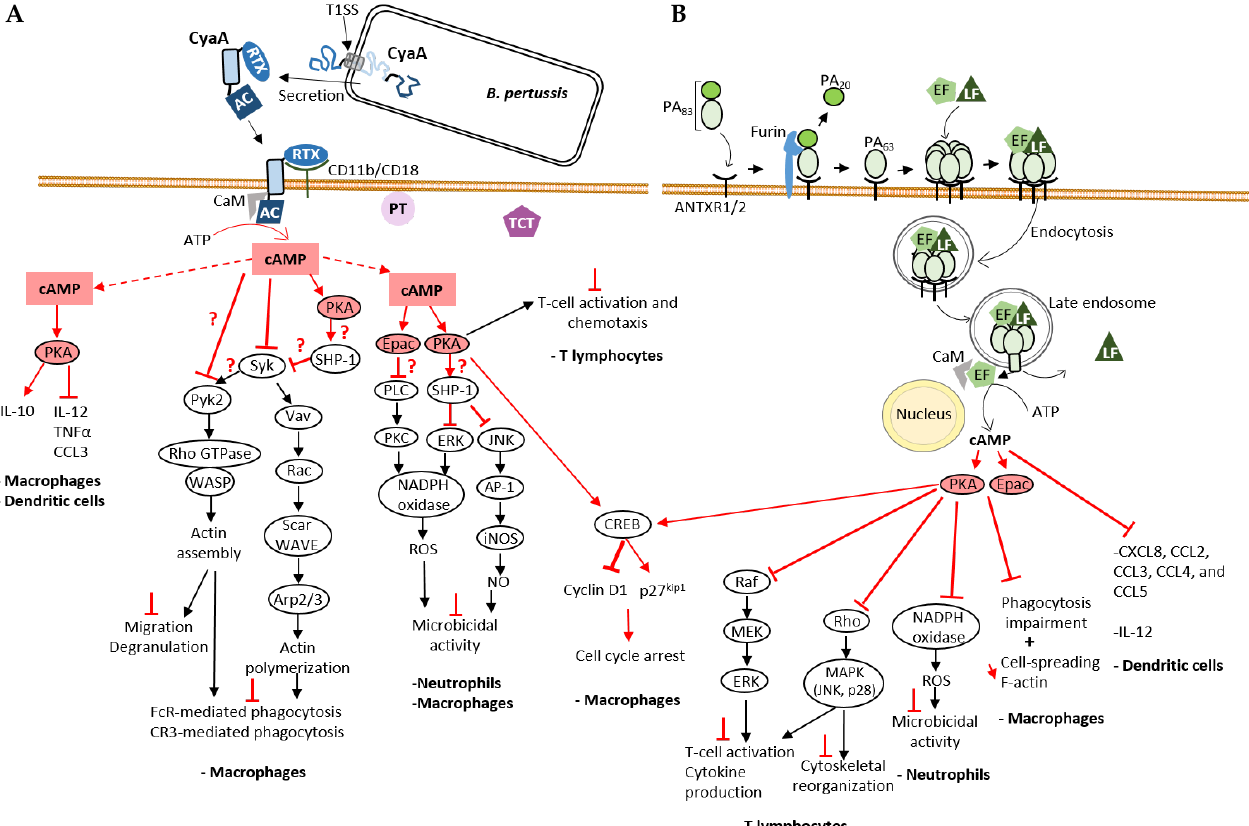
Figure 3. Mode of cell entry of CyaA and EF and their impact on cellular cAMP signaling cascades on immune cells. ( A ) cAMP-mediated processes disrupted by B. pertussis CyaA NC toxin. CyaA is one of the three major virulence factors that contribute to B. pertussis infection along with pertussis toxin (PT) and tracheal cytotoxin (TCT). A schematic of CyaA secretion through the T1SS and its cell entry mechanism, explained in detail in the text (Section 3.1), is shown here. Physiological signaling cascades are represented by black arrows for positive regulation, and the effects of bacterial toxins on signal transduction by red arrows for positive regulation, or red T-shaped bar for inhibition. A red question mark is added when the molecular mechanism is still unknown. CyaA-provoked cAMP accumulation disrupts the action of immune cells: CyaA disrupts the inflammatory response [54,55], inhibits both FcR- and CR3-mediated phagocytosis [42,56–61] and the microbicidal activity of these cells including the production of reactive oxygen species (ROS) [62,63]. ( B ) cAMP-mediated